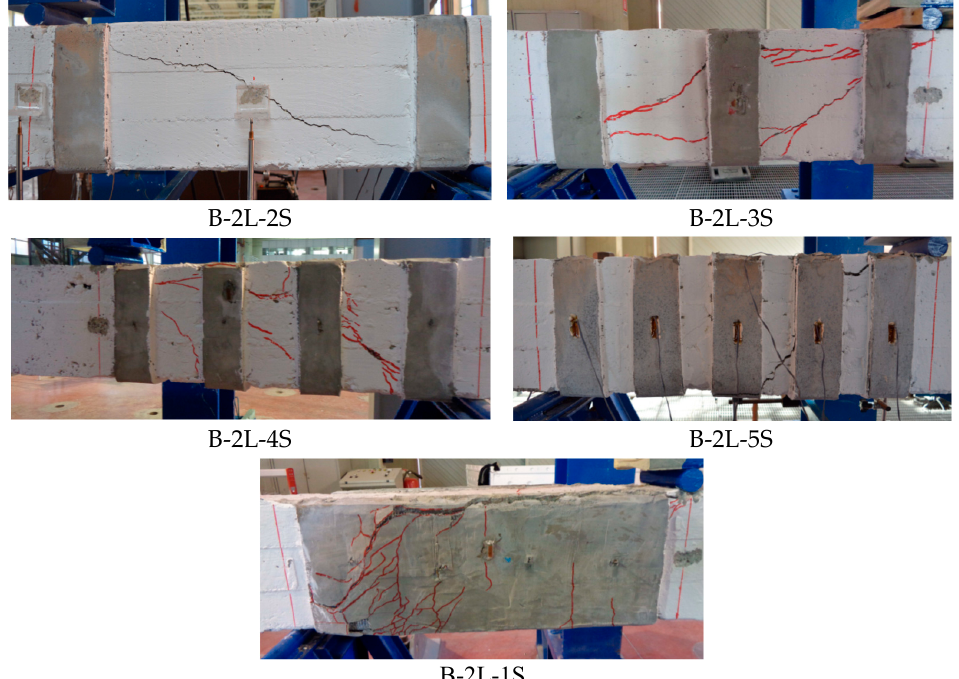
Figure 8. Failure configurations of beams strengthened with two-layer SRG U-shaped strips. At failure, the mid-length strip detached from the beam at the matrix-to-substrate interface together with a thin layer of the substrate (Figure 9). A similar failure mode was observed in the B-2L-1S beam in which the U-shaped strip detached completely from the beam.